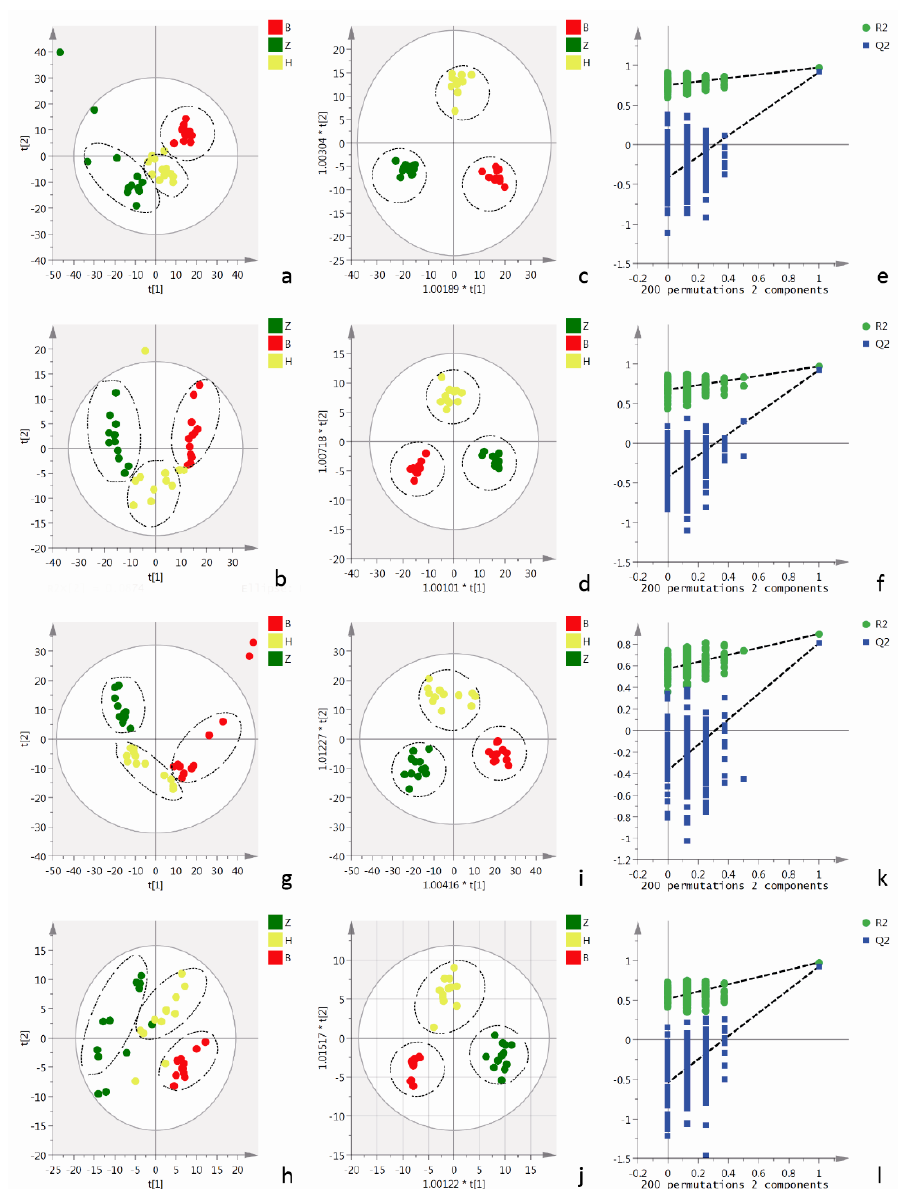
Figure 5. Multivariate analyses of data from the UPLC-Q-TOF / MS analysis of cell and cell culture supernatants stimulated with H 2 O 2 . ( a , b ): PCA score plots based on cell culture supernatant metabolic profiles of the normal, H 2 O 2 and AEE groups in positive and negative modes, ESI + : R 2 = 0.527, ESI − : R 2 = 0.593. ( c , d ): OPLS-DA score plots of the normal, H 2 O 2 and AEE groups in positive and negative modes, ESI + : R 2 X = 0.392, R 2 Y = 0.975, Q 2 = 0.862; ESI − : R 2 X = 0.511, R 2 Y = 0.966, Q 2 = 0.848. ( e , f ): Permutation test of the OPLS-DA model, ESI + : the intercepts of R 2 = 0.751 and Q 2 = − 0.427, ESI − : the intercepts of R 2 = 0.675 and Q 2 = − 0.422. ( g , h ): PCA score plots based on the cellular metabolic profiles of the normal, H 2 O 2 and AEE groups in positive and negative modes, ESI + : R 2 = 0.56, ESI − : R 2 = 0.668. ( i , j ): OPLS-DA score plots of normal and AEE groups in positive and negative modes, ESI + : R 2 X = 0.4, R 2 Y = 0.911, Q 2 = 0.836; ESI − : R 2 X = 0.531, R 2 Y = 0.924, Q 2 = 0.814. ( k , l ): Permutation test of the OPLS-DA model, ESI + : the intercepts of R 2 = 0.568 and Q 2 = − 0.0.375, ESI − : the intercepts of R 2 = 0.518 and Q 2 = − 0.545. Z: normal group; B: AEE group; H: H 2 O 2 group.